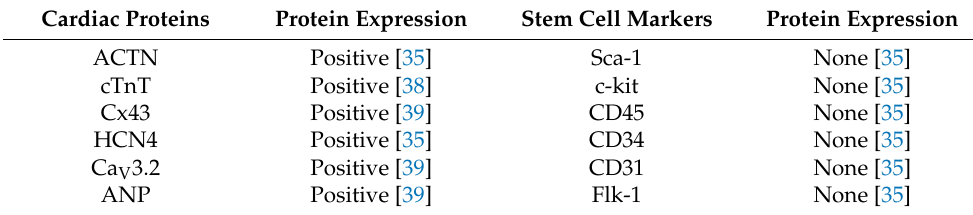
Table 1. Protein expression in